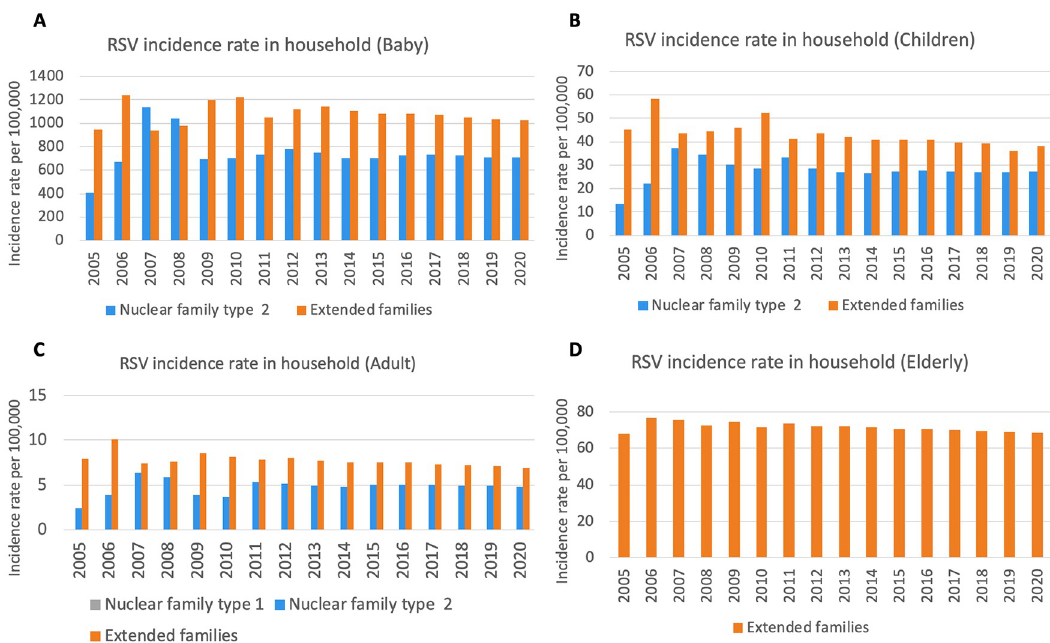
2, and orange color: extended family.